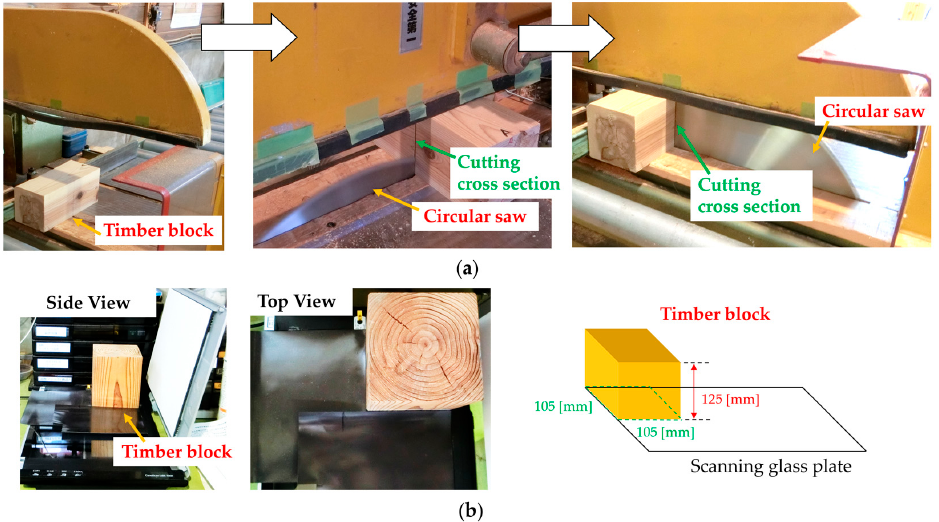
Figure 5. Scenes for timber processing and image acquisition. ( a ) Cutting scene of square timber; ( b ) Image of the cross-section is scanned using a scanner.